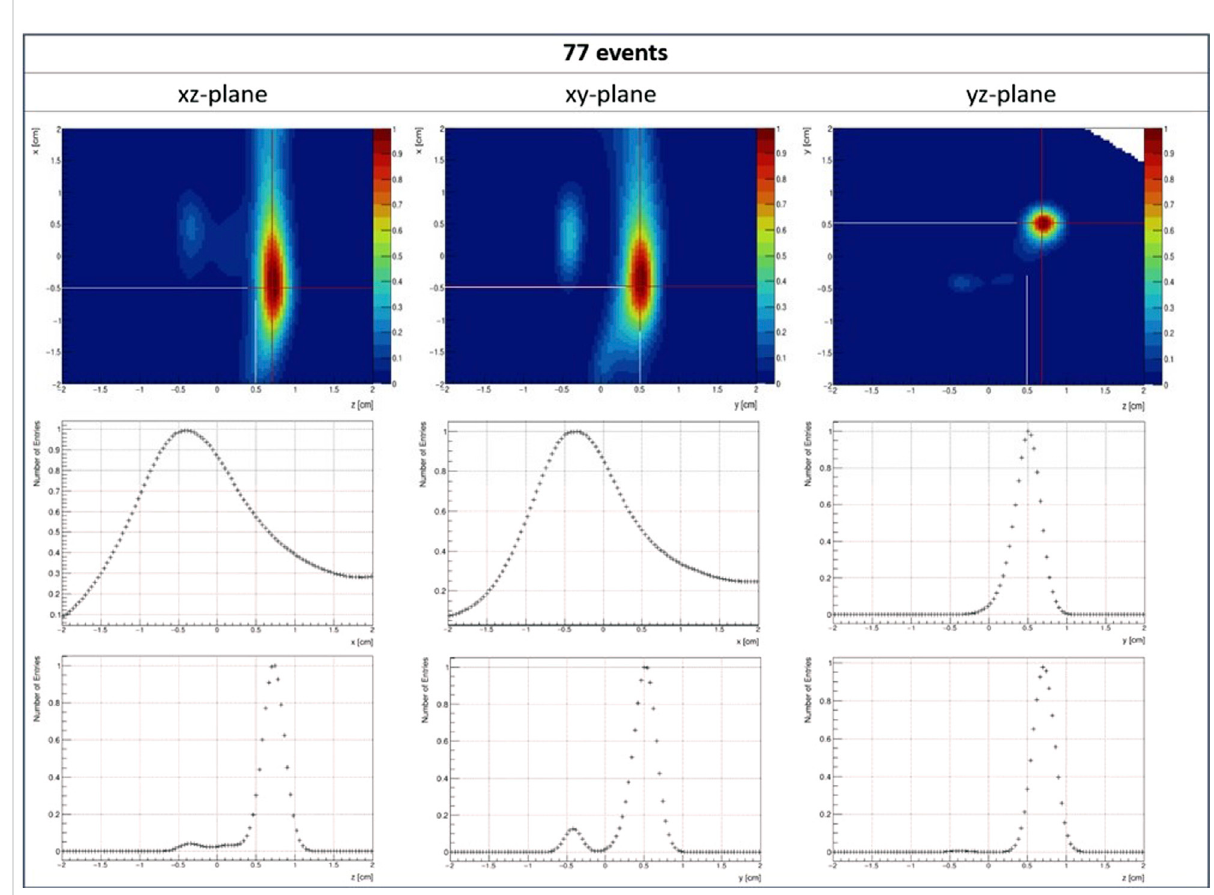
FIGURE 8 Reconstructed imageofa 22 Na point source located atan off-center position(x= 5 mm, y = − 5 mm, z = − 5 mm) inthexz-(left), xy-(center) and yz-plane (right). The intersection of the (extrapolated) white lines indicates the source position and the red lines represent the bin for which the 1D projection is shown in the center and bottom row. Furthermore, an artefact that corresponds to the second intersection of the LOR and the Compton cone is visible at the inverse source position (x = 5 mm, y = − 5 mm, z = − 5 mm) in all three 2D images.